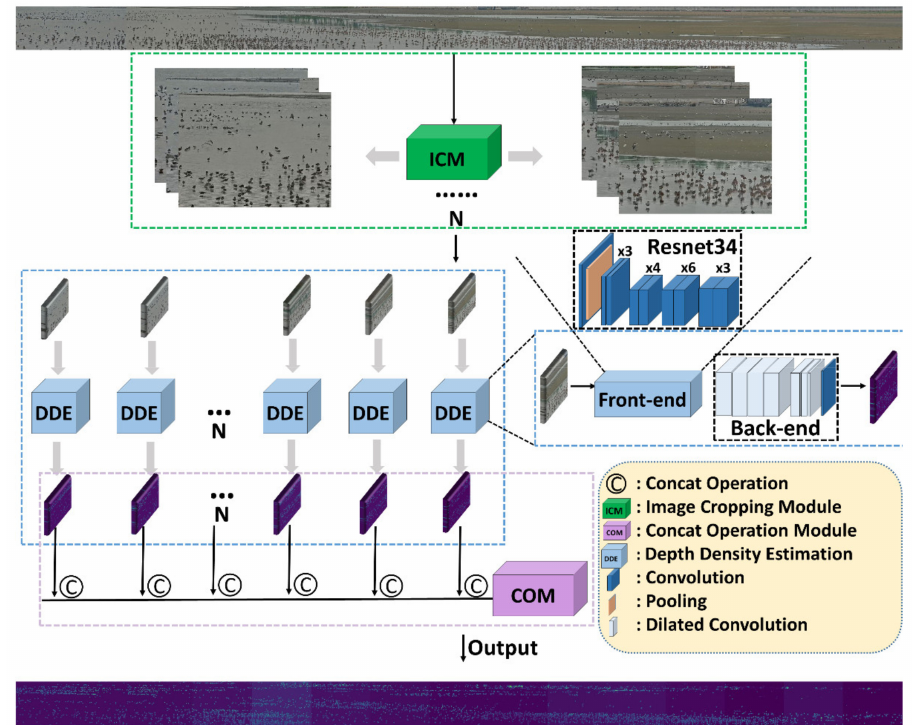
Figure 4. The architecture of panorama bird population counting network. It consists of three parts, the green part is the image cropping module, the blue part is the depth density estimation network, and the purple part is the concat operation